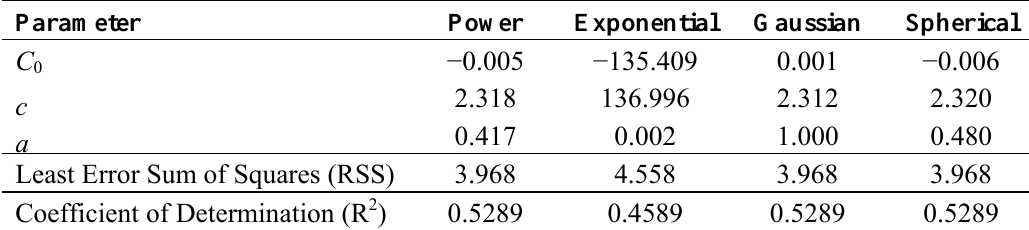
Table 3. Parameters of the four fitted theoretical semivariograms.